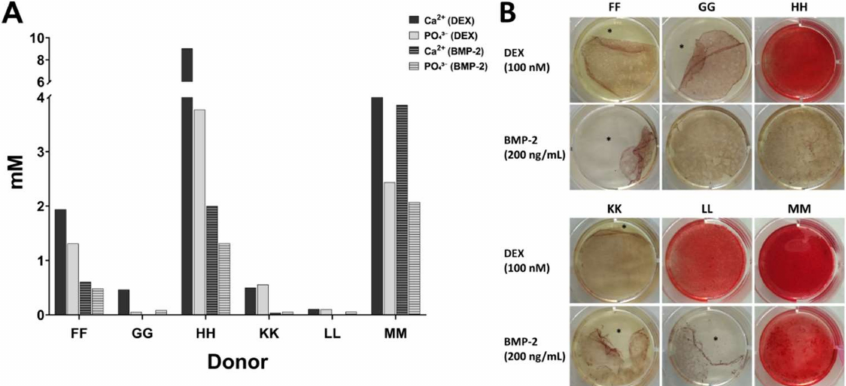
Figure 1. Osteogenic differentiation in vitro. Differentiation was performed for 27 days as described in Materials and Methods (cf. Supplemental Table S1 for information on donors). ( A ) Quantification of calcium ions and phosphate ions. ( B ) Alizarin Red S-staining to detect calcium ions in the cell layer. Some wells demonstrate cell layers which detached during the staining procedure (denoted by